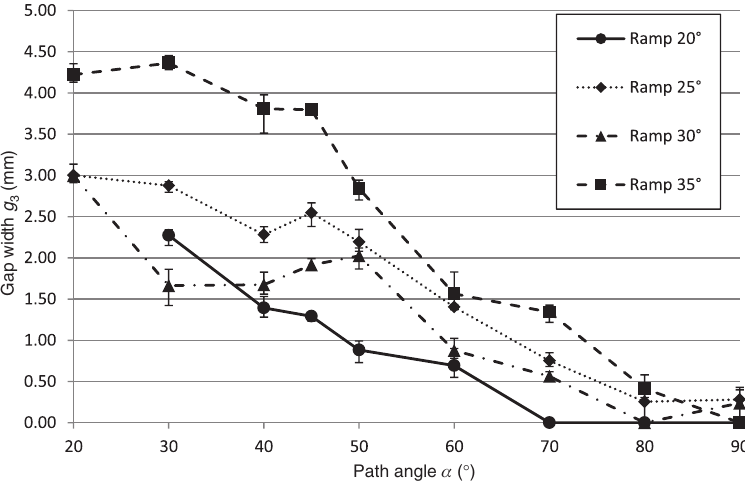
Figure 28 Experimental gap width g